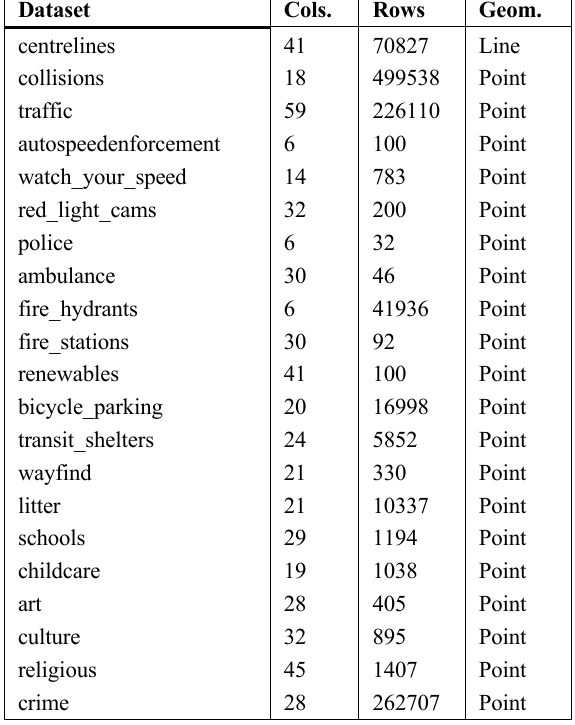
Table 3 . Data used for Toronto traffic collision